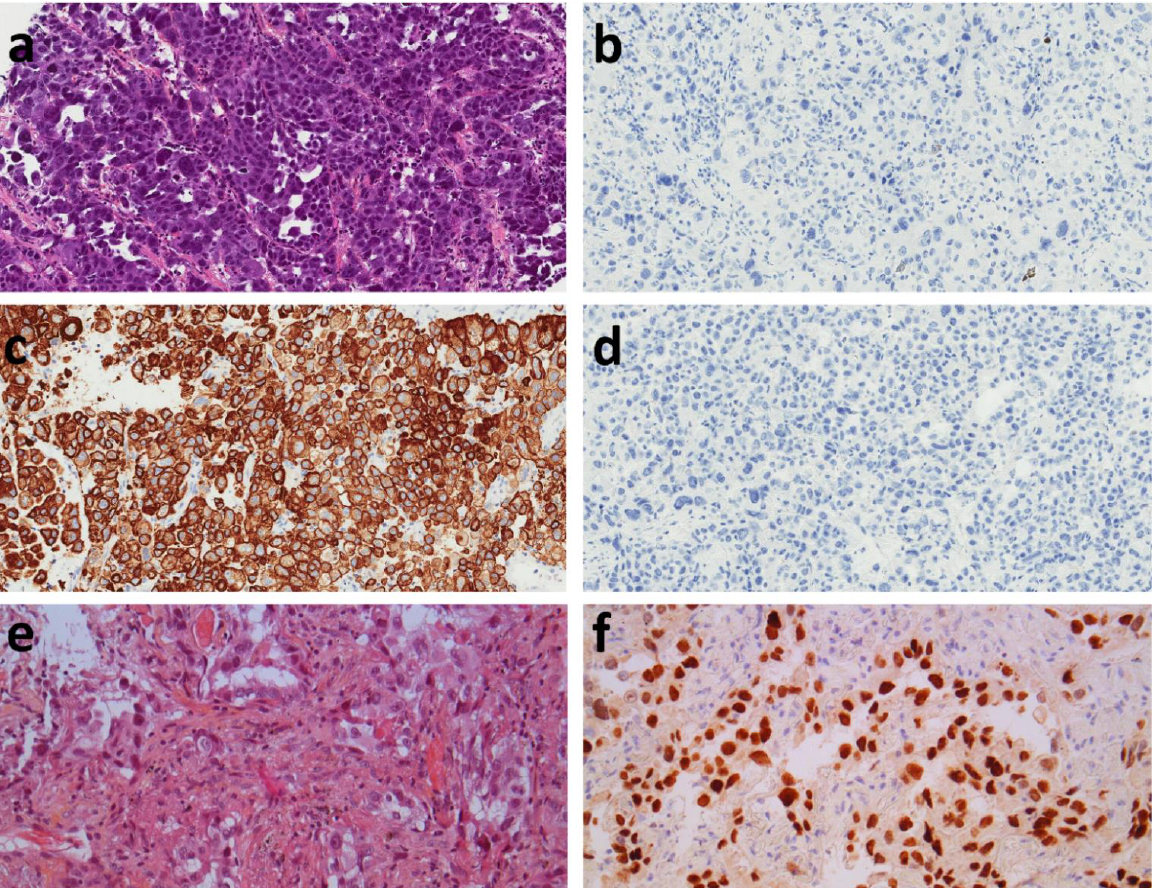
Figure 2. Illustrative microphotograph of TTF-1 negative, CK7 positive, and CK20 negative lung carcinoma. ( a ) Hematoxylin Eosin, ×200, showing a lung carcinoma without neuroendocrine morphology. ( b ) TTF-1 immunohistochemistry, ×200, tumor cells are not stained. ( c ) CK7 immunohistochemistry, ×200, showing a diffuse staining of tumor cells. ( d ) CK20 immunohistochemistry, ×200, tumor cells are not stained. ( e ) Hematoxylin Eosin, ×200, showing a lung carcinoma without neuroendocrine morphology. ( f ) TTF-1 immunohistochemistry, ×200, nuclear staining of tumor cells.